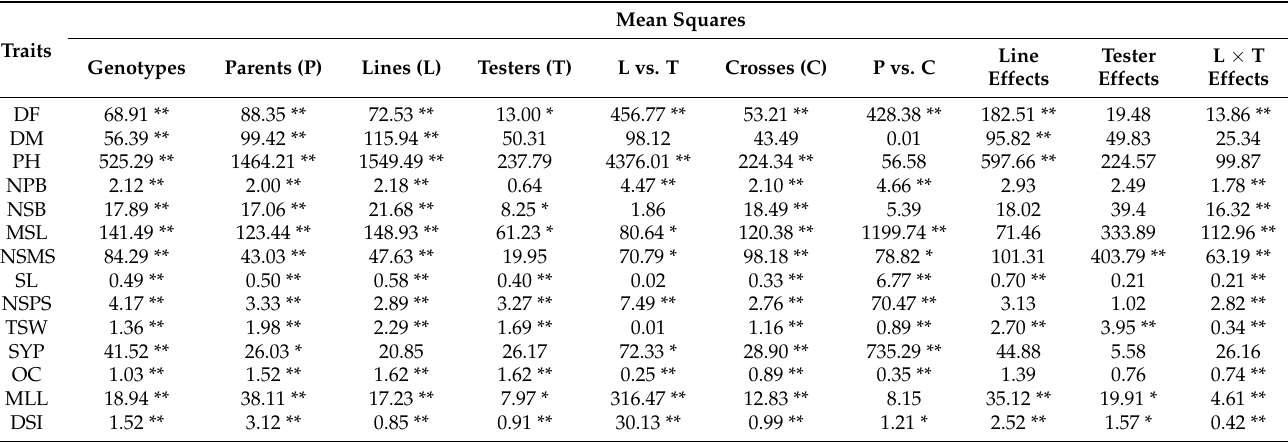
Table 2. ANOVA of Line × Tester analysis for seed yield and its component traits and Sclerotinia stem rot resistance in Indian